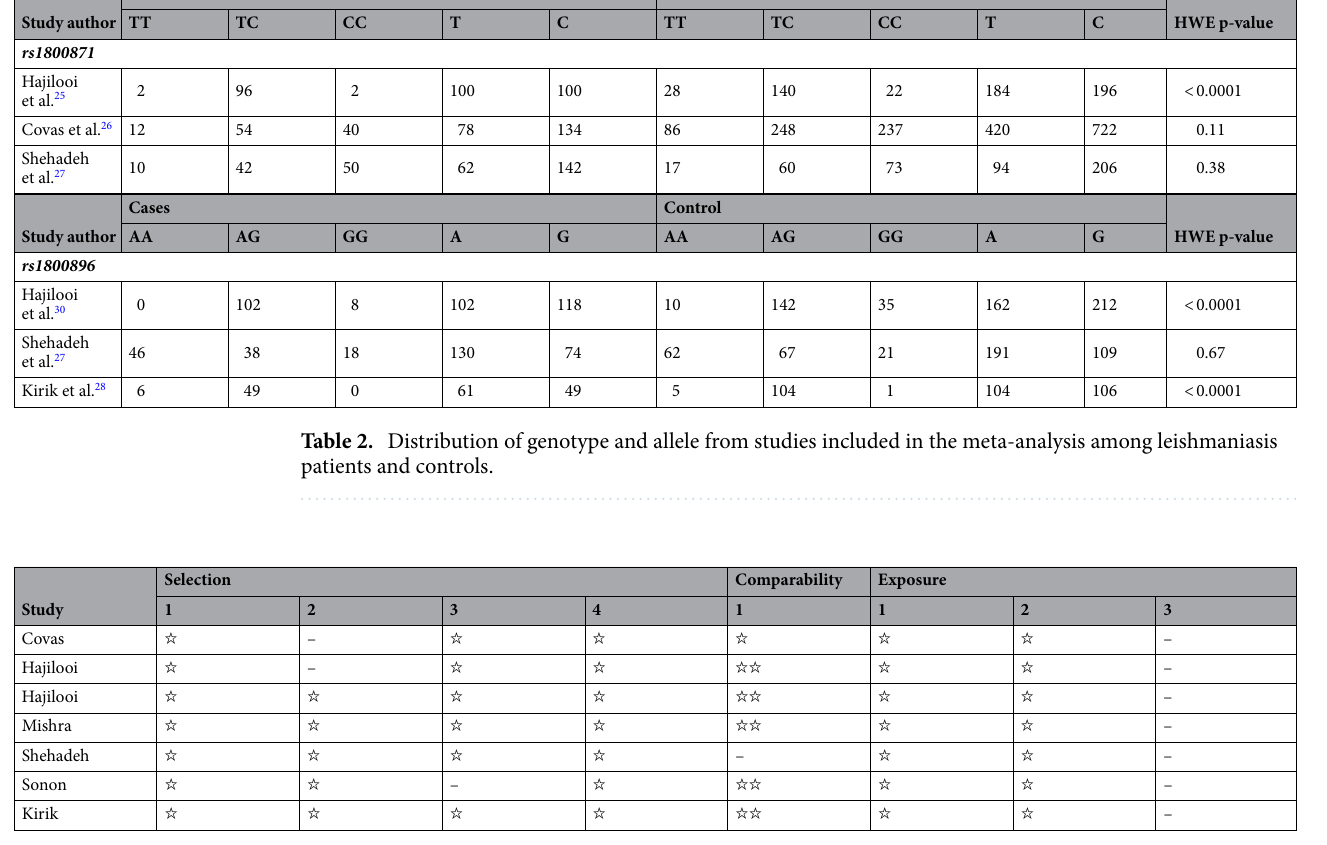
Table 3. Risk of bias of the included studies in the systematic review using the tool Newcastle–Ottawa (NOS) quality assessment scale for case–control studies. Selection: 1. Adequate case definition; 2. Representativeness of the cases; 3. Selection of controls; 4. Definition of controls. Comparability: 1. Comparability of cases and controls on the basis of the design or analysis. Exposure: 1. Ascertainment of exposure; 2. The same method of ascertainment for cases and controls; 3; Non-response